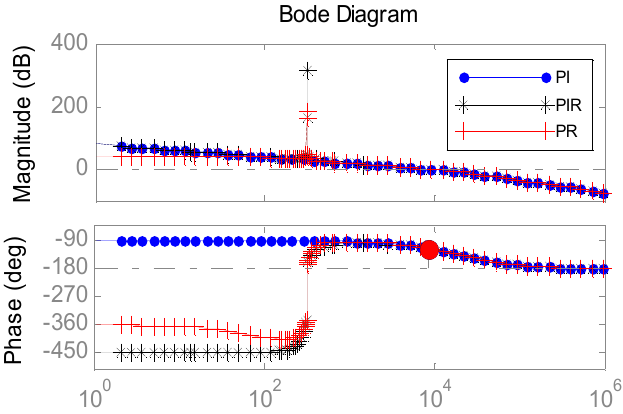
( b ) Figure 14. Common-mode voltage. ( a ) Common-mode voltage of modulation mode I, θ = 30°. ( b ) Common-mode voltage of HMM, θ =30°. Based on the system parameters from Table I earlier, the open loop and closed loop transfer function of the system under the PI, PR, and PIR controllers can be easily obtained. Both the open and closed loop bode plots for three controllers are shown in Figures 15 and 16 respectively. It should be noted that the closed loop bode plots in Figure 15 are obtained from the systems which have already been controlled. As can be seen from Figure 14, the gain at the resonant frequency under the